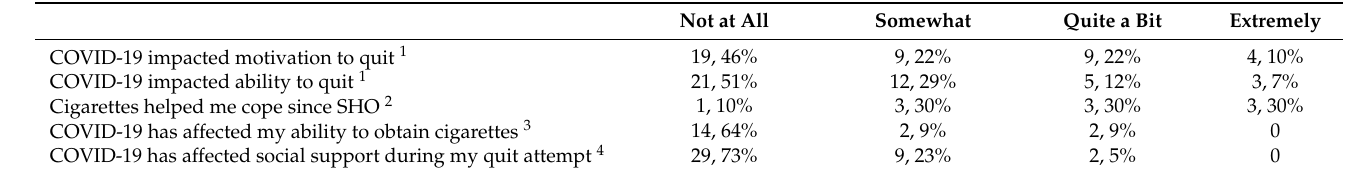
Table 3. Impact of COVID on